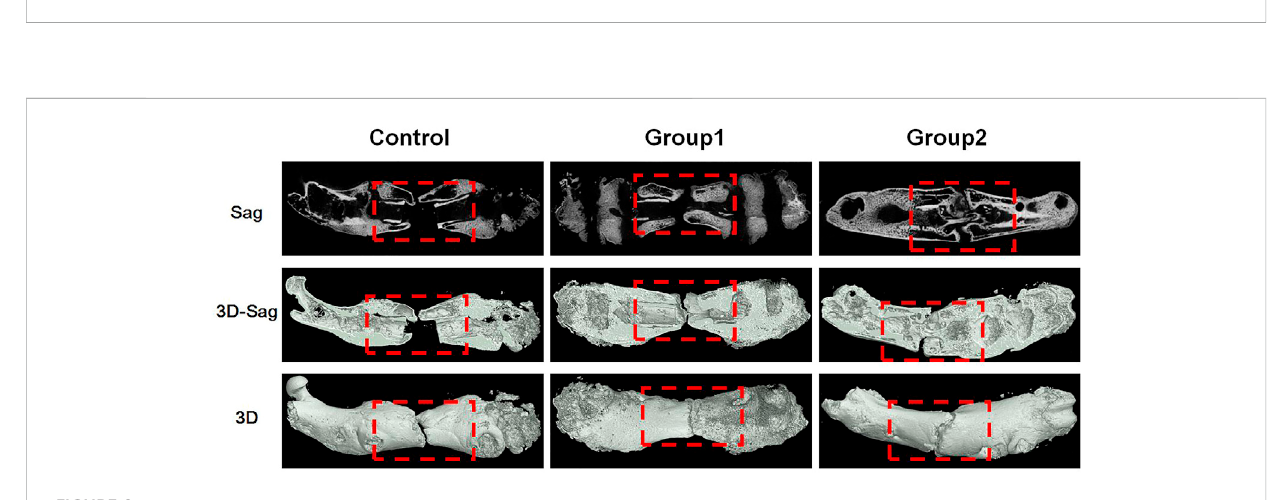
FIGURE 9 Micro-CT images of femurs in each group at the 8th